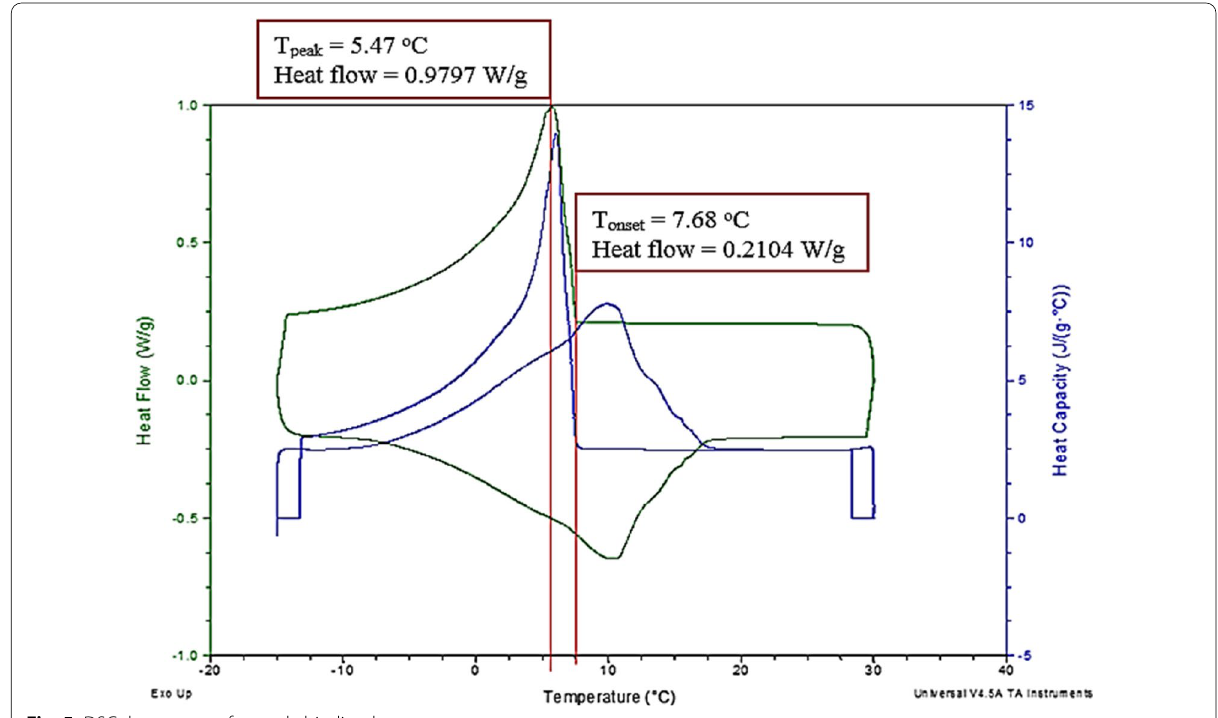
Fig. 5 DSC thermogram for crude biodiesel